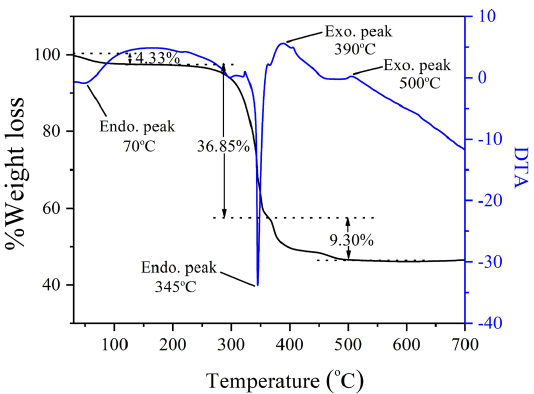
Cr Ni O 0.15 0.02 0.83